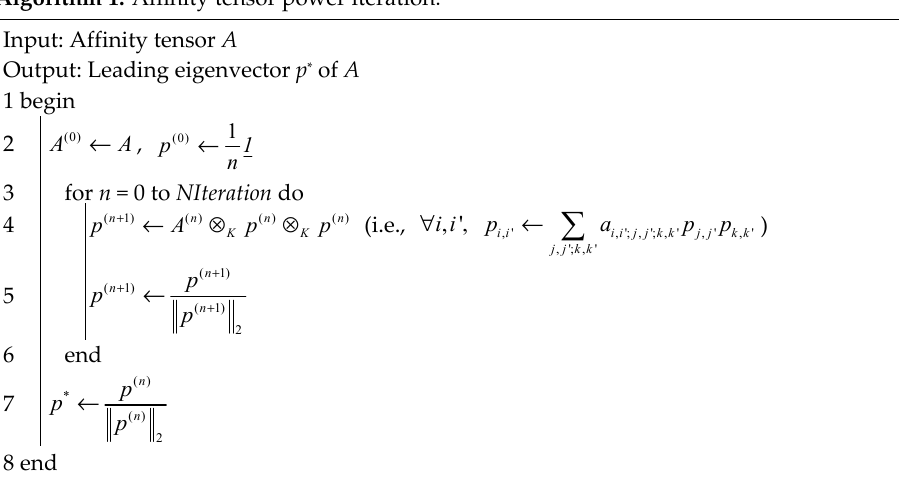
Algorithm 1: Affinity tensor power iteration.